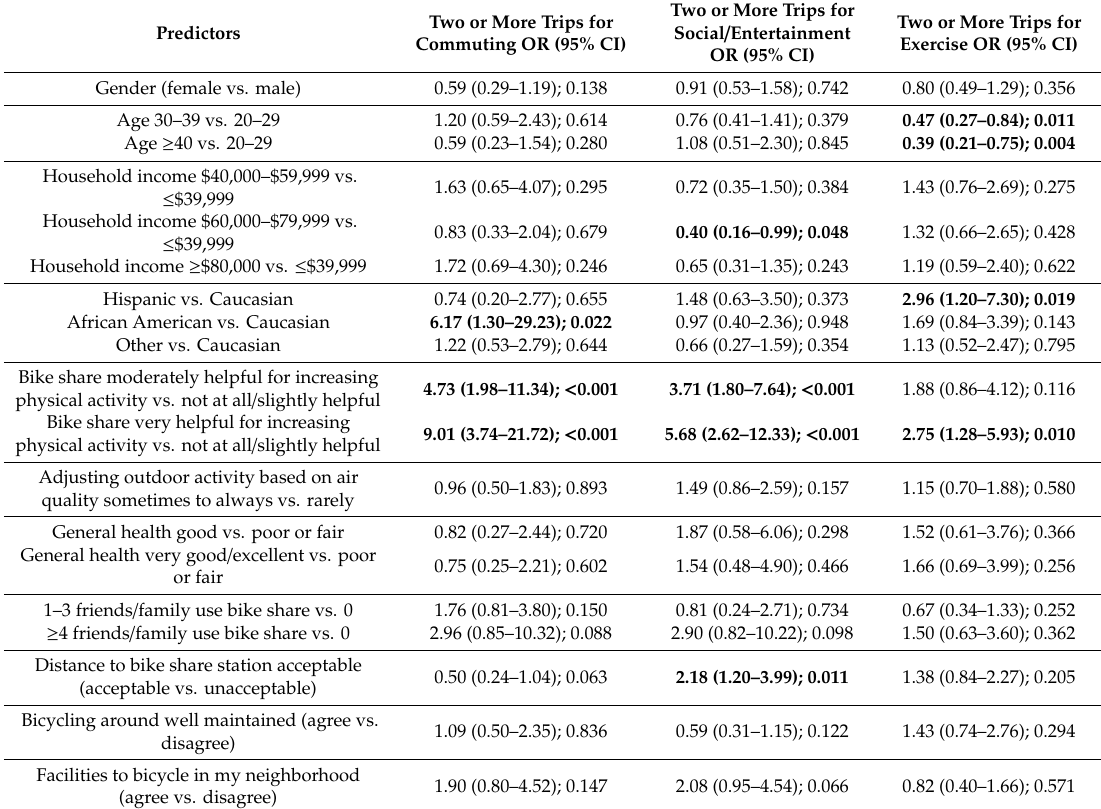
Table 2. Likelihood of making two or more trips per week in the past six months for commuting, social / entertainment, and exercise. Significant predictors are in